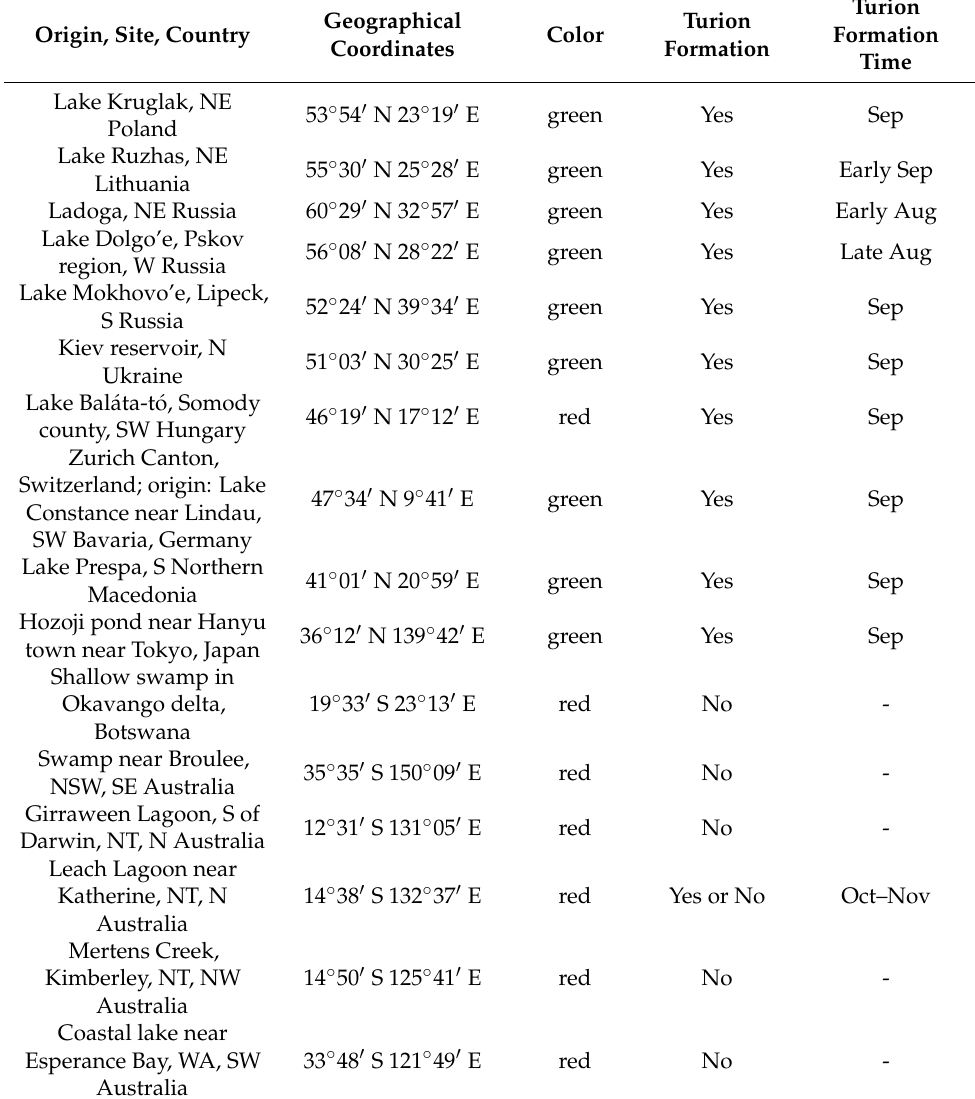
Table 1. List of 16 accessions of Aldrovanda vesiculosa used for phytochemical analyses. Geographical Origin, Site, Country